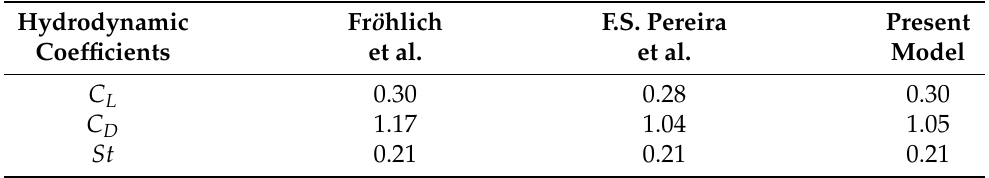
Table 2. Hydrodynamic coefficients of a single circular cylinder simulated for a subcritical Reynolds number ( Re = 3900) flow field: Comparison between the present model and the results of other studies